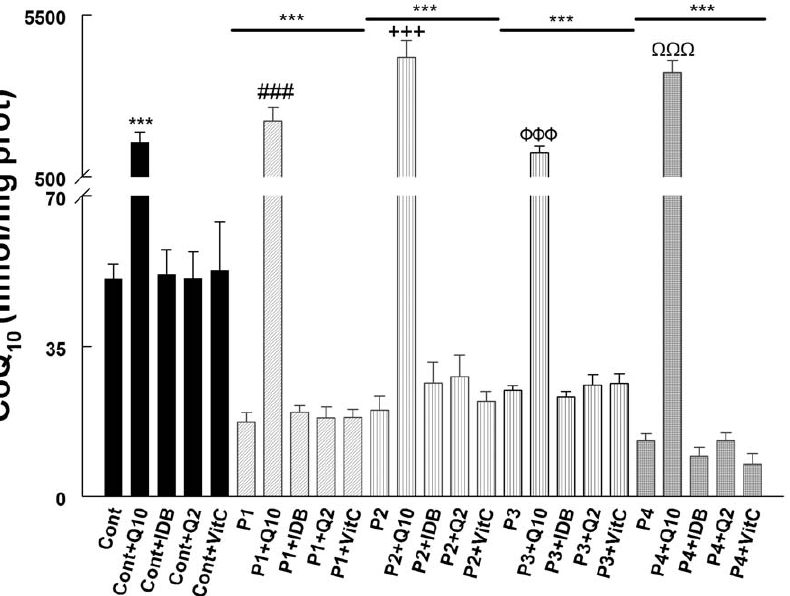
Figure 2. Cellular CoQ 10 levels after 24 hours of treatment. Cultured skin fibroblasts from controls and CoQ 10 deficiency patients were treated with 5 m M CoQ 10 , idebenone, CoQ 2 or vitamin C. After 24 hours, fibroblasts were collected and cellular CoQ 10 were determined by EQ-HPLC. Results are expressed as a mean 6 SD of three experiments. P1= COQ9 mutant; P2= COQ2 mutant; P3= COQ2 mutant; P4= PDSS2 mutant. *** P , 0.001 compared with untreated control; ### P , 0.001 compared with untreated P1; +++ P , 0.001 compared with untreated P2; www P , 0.001 compared with untreated P3; V V V P , 0.001 compared with untreated P4.